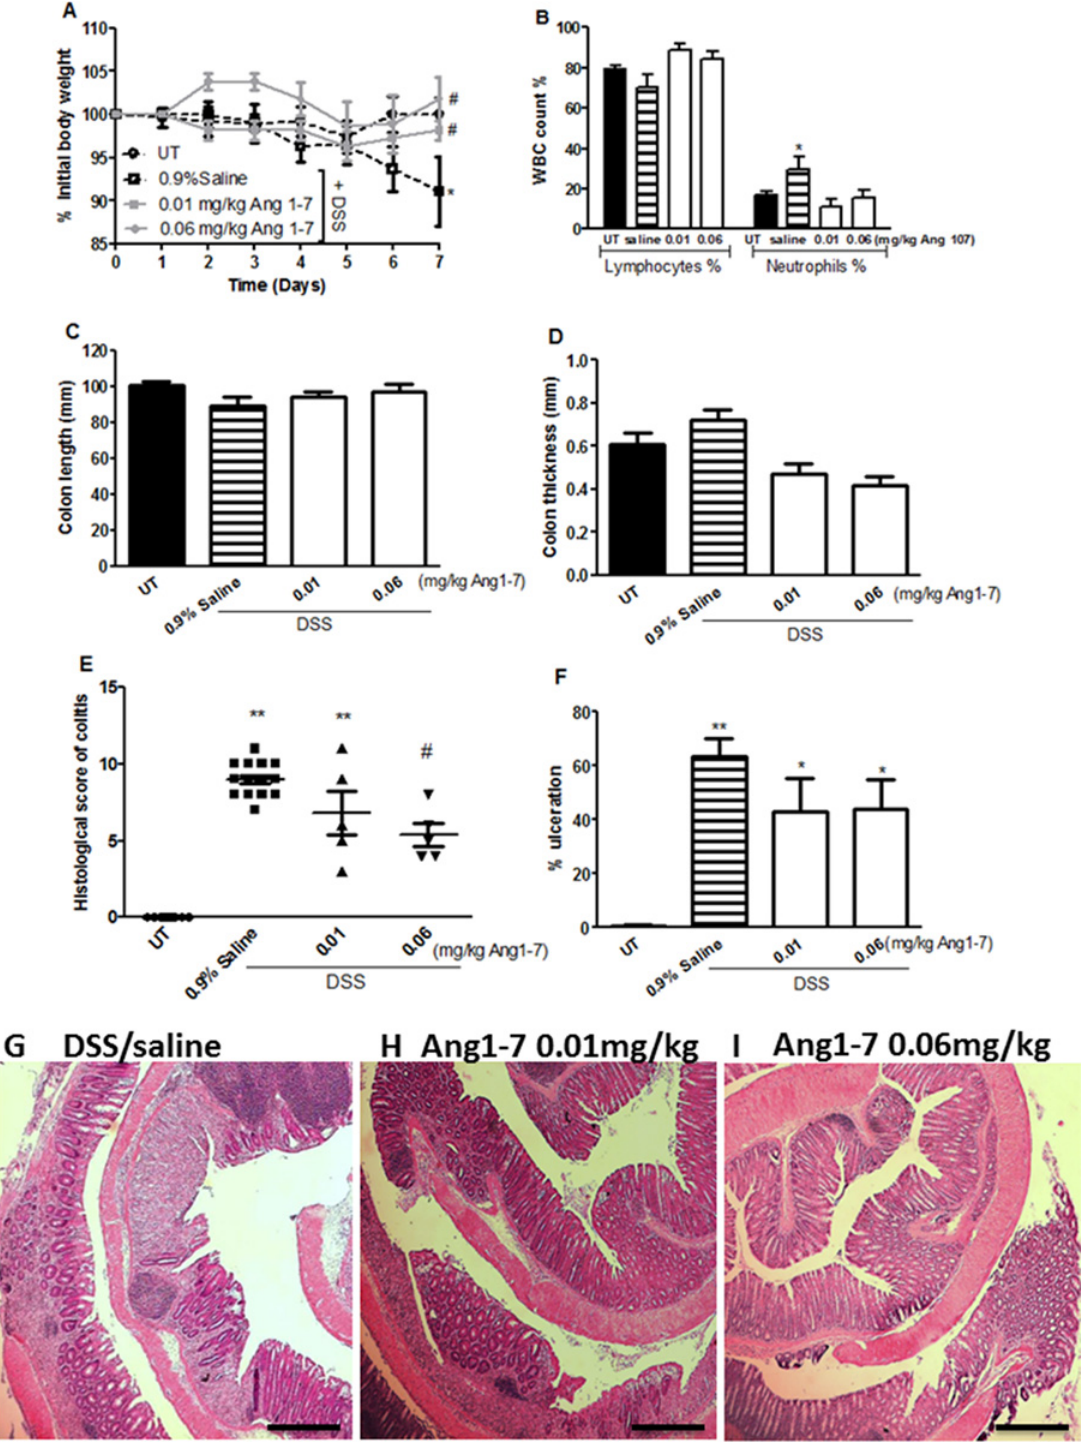
Fig 5. Effect of Ang 1 – 7 treatment on established colitis. Panel A shows % body weight change in mice injected daily (for 3 days) with saline (hatched line, open squares) or Ang 1 – 7 (gray lines) post-DSS administration (given for 4 days) compared to UT mice receiving tap water only throughout (hatched line, open circles). Panel B shows % of circulating lymphocytes and neutrophils. Colon length (panel C) and thickness (panel D) was determined in saline (hatched bars) or Ang1-7 treated DSS mice (open bars) compared to UT group (solid bars). Panels E and F represent quantitatively the histological assessment of colitis severity and the % of ulceration in the whole colon section for each group as indicated. Histobars represent means ± SEM for 5 – 18 mice